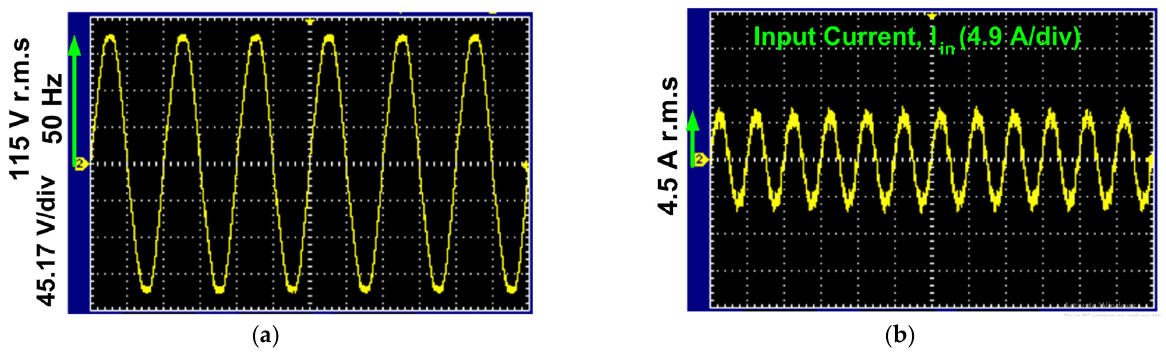
Figure 23. Experimentally obtained: ( a ) input voltage; and ( b ) input current.